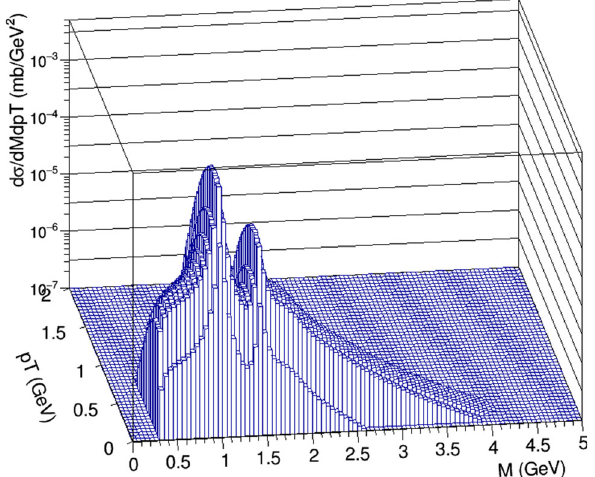
Fig. 11 Contributions of the f 0 (500) resonance, the f 1 , f 2 and the Pomeron trajectory, and of the background to the meson differential cross section d σ /dM at hadron